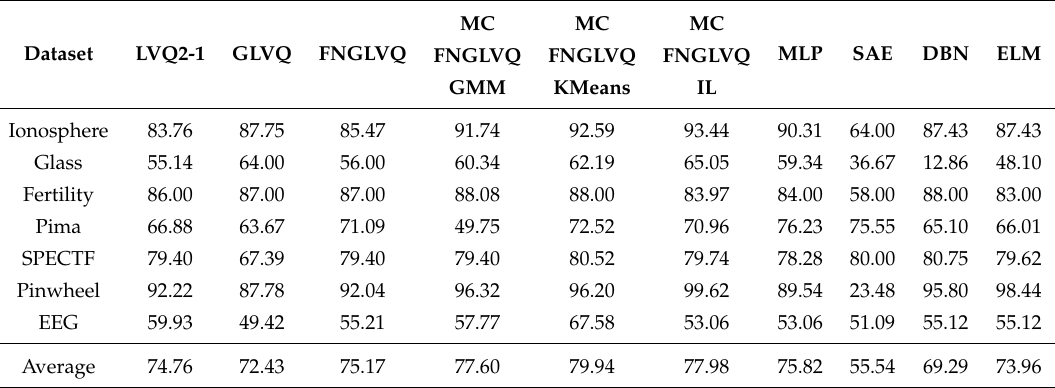
Table 4. Comparison on Benchmark Dataset.